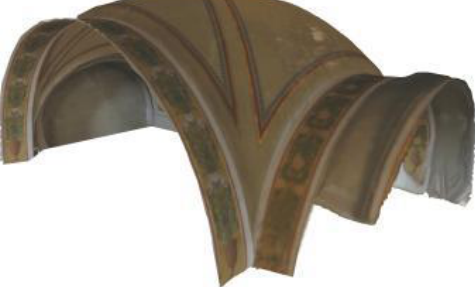
Figure 3. Photogrammetric restitution of the vault